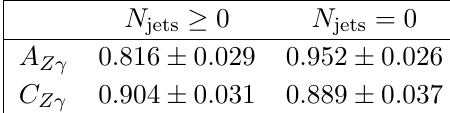
Table 4 . Summary of values of the correction factors ( C Z(cid:13) ) and acceptances ( A Z(cid:13) ) for the Z(cid:13) cross-section measurements. The uncertainty presented here includes only systematic components, since the statistical uncertainty is found to be